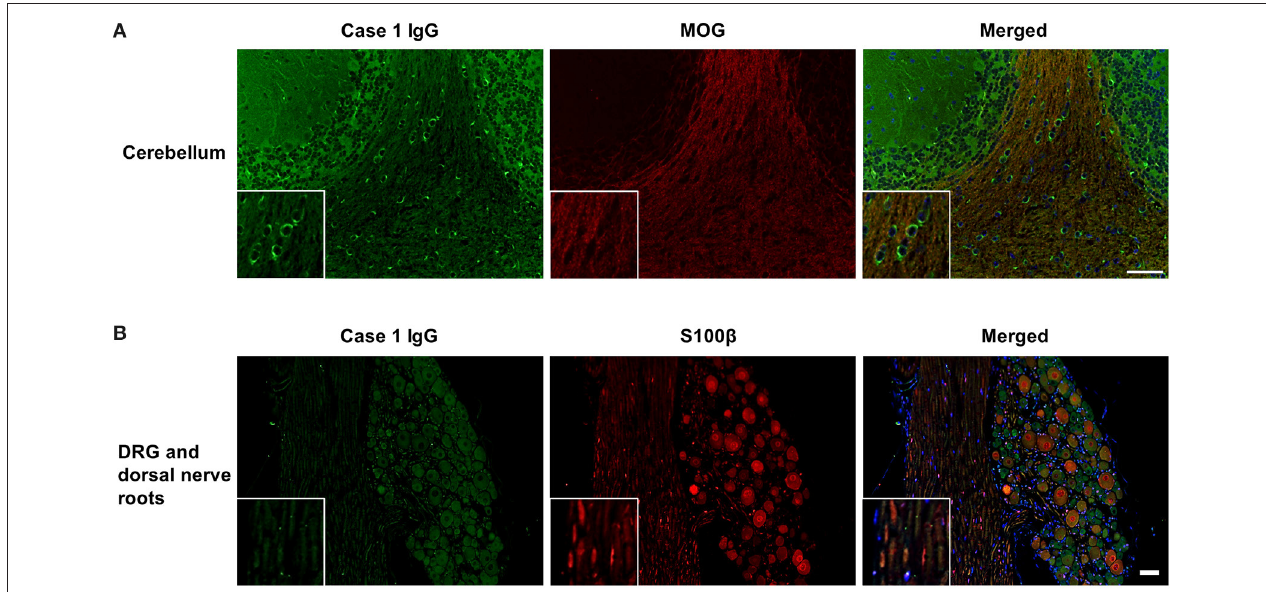
FIGURE 3 | Dual immunostaining of mouse cerebellum using patient IgG and anti-MOG antibodies and of mouse DRG and dorsal nerve roots using anti-S100 β antibodies . (A) Immunostaining of MOG (red), expressed in myelin sheaths but less frequently in the cytoplasm of oligodendrocytes, did not co-localize with IgG binding (green) from a representative MS patient with anti-oligodendrocyte antibodies (Case 1 in Figure 1 ). (B) IgG (green) from a representative MS patient with anti-oligodendrocyte antibodies (Case 1 in Figure 1 ) showed no significant immunoreactivity to mouse DRG neurons and dorsal nerve roots including S100 β -positive Schwann cells (red) from the peripheral nervous system. Scale bar = 50 µ m. DRG, dorsal root ganglion; IgG, immunoglobulin G; MS, multiple sclerosis; MOG, myelin oligodendrocyte